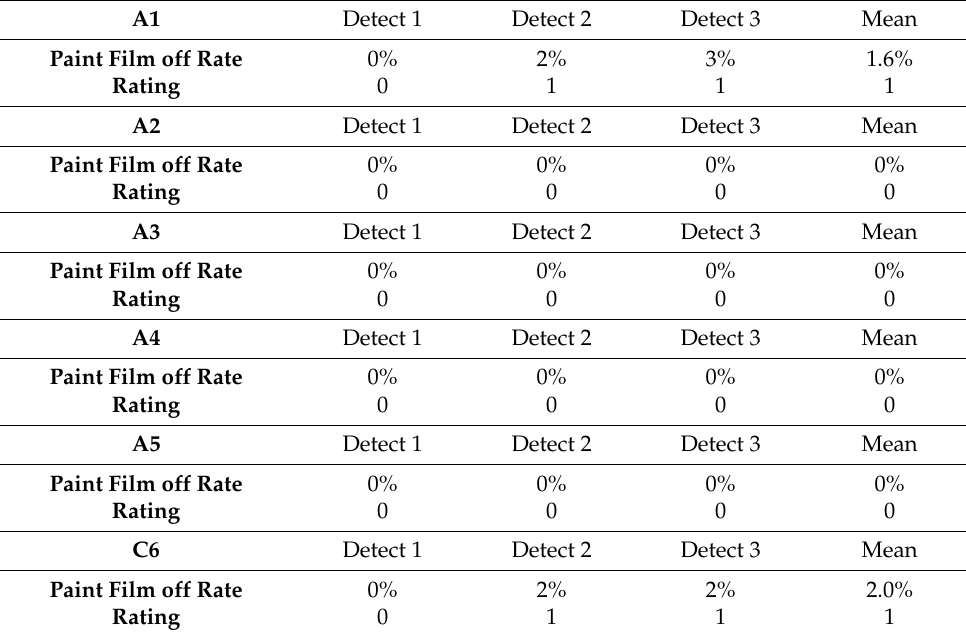
Table 9. The measured value of adhesion of paint film for Group